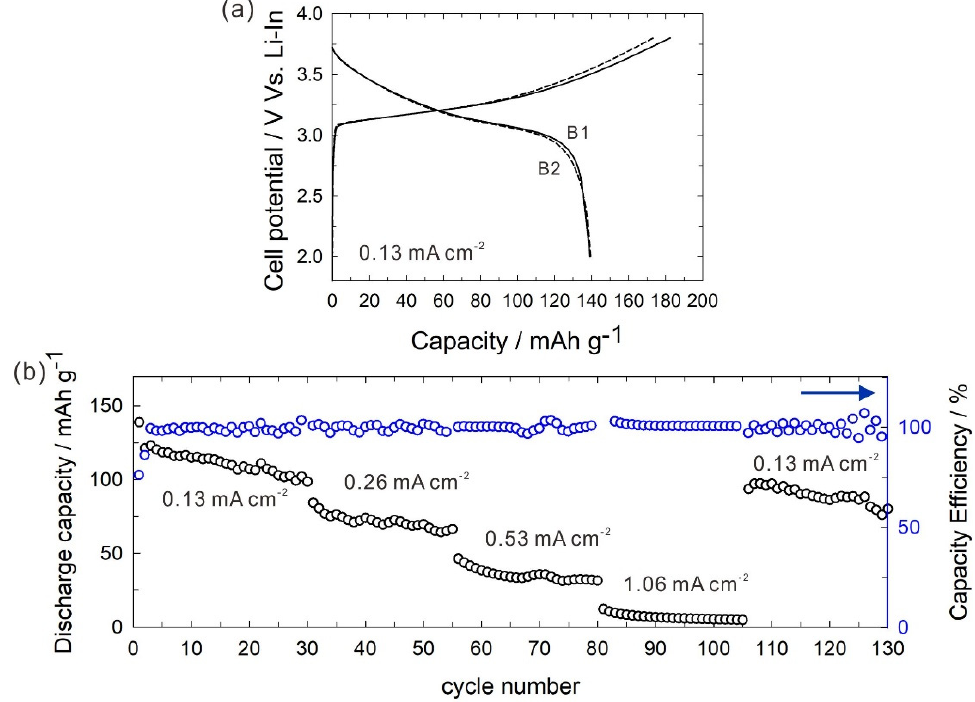
Figure 6. ( a ) First charge–discharge curves at 2.0 to 3.8 V vs. Li–In alloy (2.6 to 4.2 V vs. Li), and ( b ) cycle